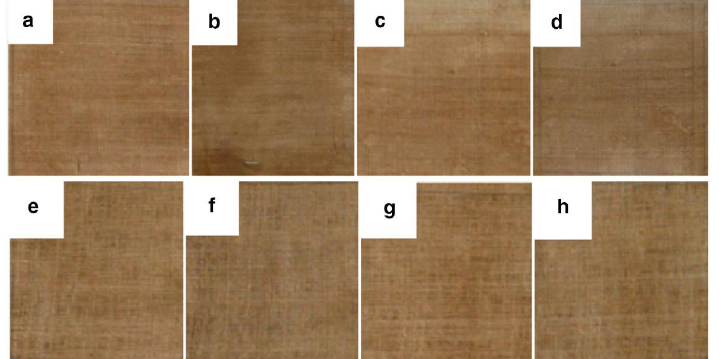
Figure 7. Real linen canvas with high-density weaving before ( a ) and after ( b ) treatment with polar nanocomposite and before ( c ) and after ( d ) treatment with non-polar nanocomposite; real linen canvas with low-density weaving before ( e ) and after ( f ) treatment with polar nanocomposite and before ( g ) and after ( h ) treatment with non-polar nanocomposite. Reproduced under terms of the CC-BY license [24]. Copyright © 2020, The Authors, published by Springer Nature.